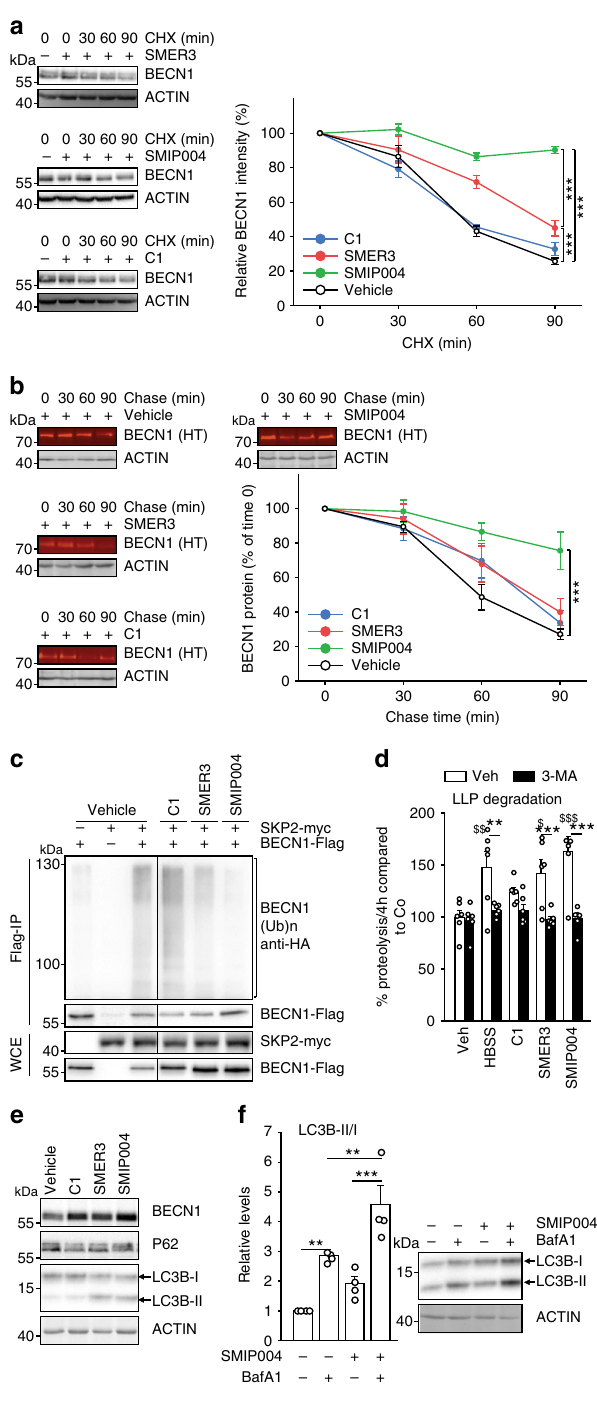
viruses showed overall an up to 10-fold decreased replication in both WT and Atg5 knockout cells compared to WT virus suggesting a p4b- and p5-dependent attenuation of virus replication that is independent of ATG5-directed autophagy. SKP2 inhibition reduces MERS-CoV replication . The in fl uence of MERS-CoV infection on SKP2 phosphorylation, BECN1 degradation and its inhibition of the autophagic fl ux encouraged us to test if SKP2 inhibitors (such as SKP2i) may limit MERS- CoV ampli fi cation in infected cells. Indeed, SKP2i caused